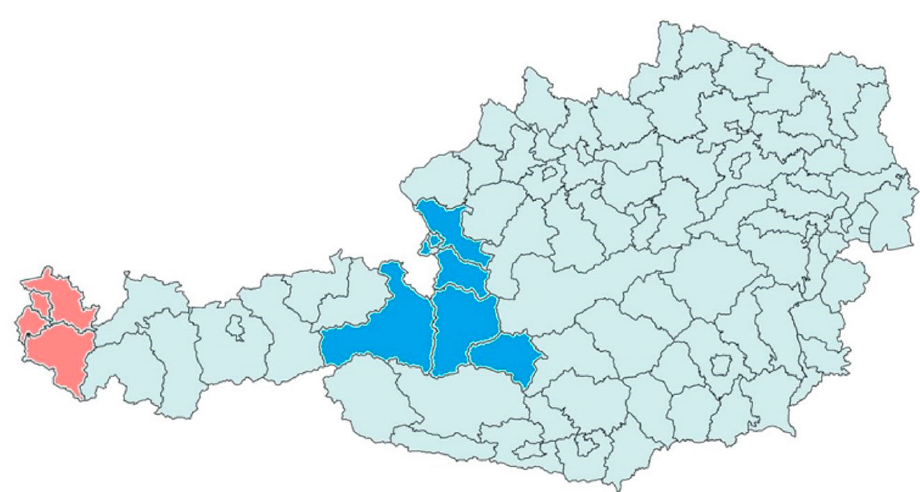
Figure 1. Map of Austria and its political districts. Colored districts correspond to those containing the 6 WWTPs monitored in Salzburg (blue) and the 5 WWTPs in Vorarlberg (red), covering in total 0.7 Mio inhabitants.